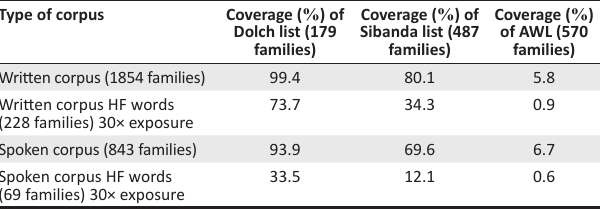
FIGURE 1: Distribution of teacher talk and textbook talk in percentage per word frequency TABLE 4: Corpora coverage of Sibanda list, Dolch list and Academic Word List.